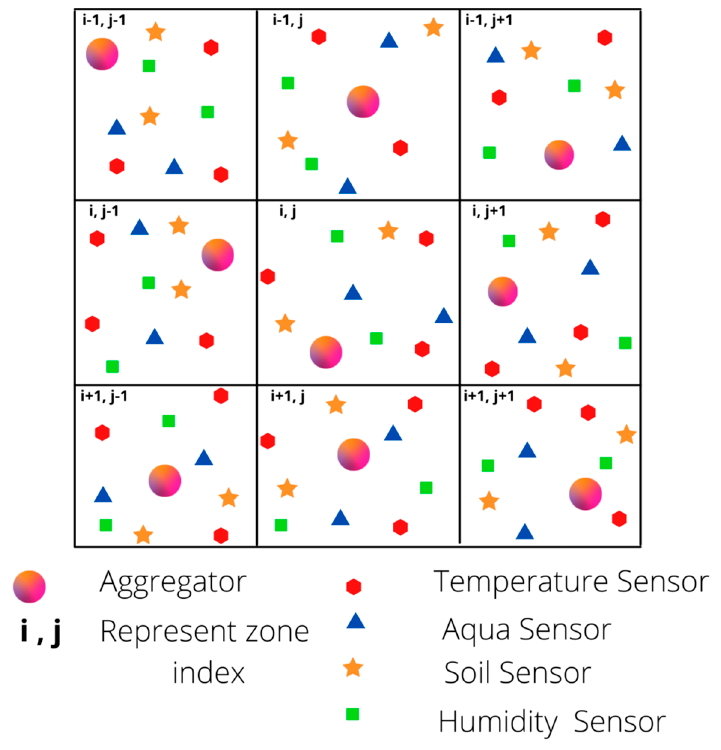
Figure 1. Network Model.